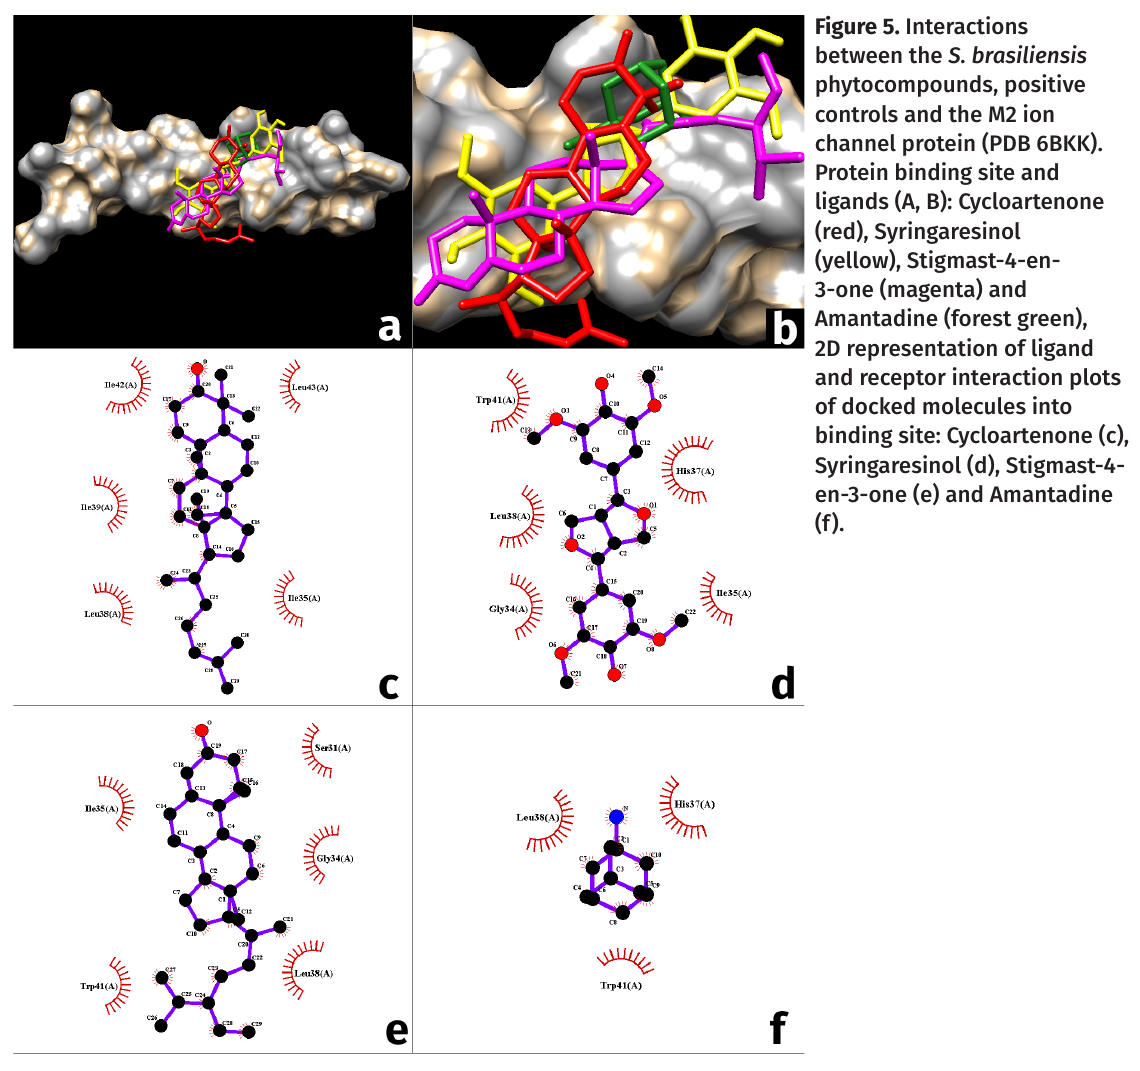
Figure 5. Interactions between the S. brasiliensis phytocompounds, positive controls and the M2 ion channel protein (PDB 6BKK). Protein binding site and ligands (A, B): Cycloartenone (red), Syringaresinol (yellow), Stigmast-4-en- 3-one (magenta) and Amantadine (forest green), 2D representation of ligand and receptor interaction plots of docked molecules into binding site: Cycloartenone (c), Syringaresinol (d), Stigmast-4- en-3-one (e) and Amantadine